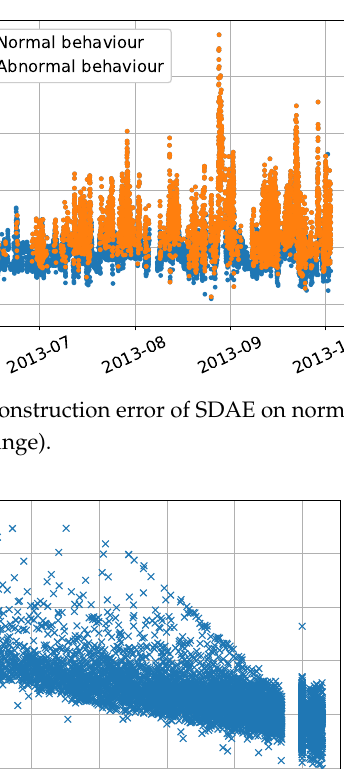
Figure 16. Normalized power estimated by SDAE on test set with respect to normalized power simulations.